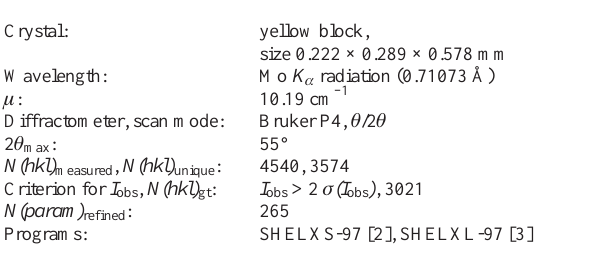
Table 1. Data collection and handling.